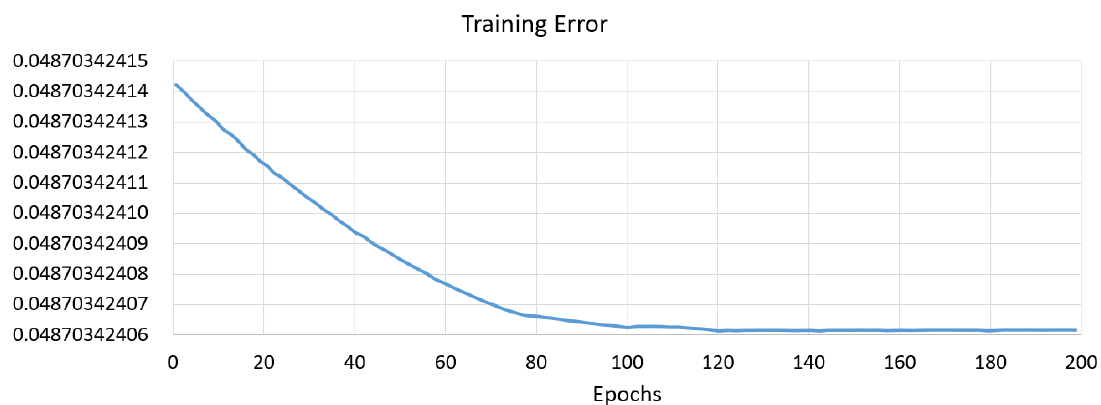
Figure 6. Training Error in dimensional Error X.